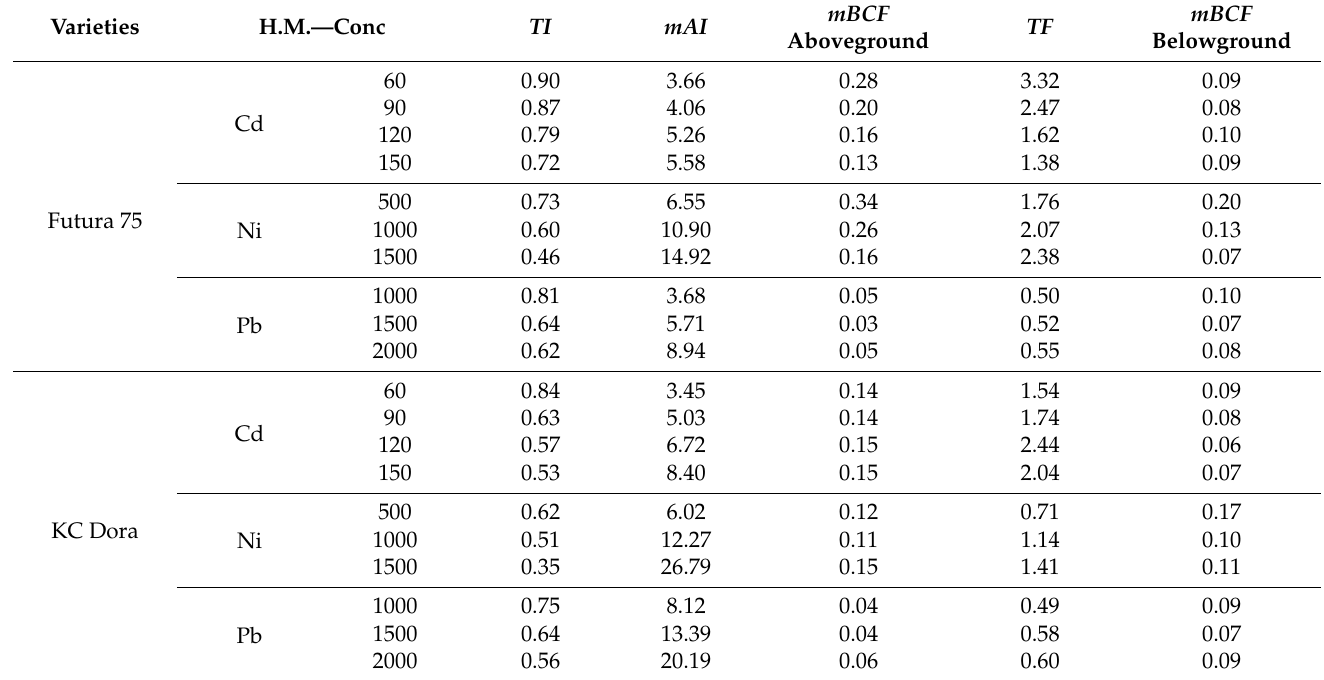
Table 6. Phytoremediation indices and factors of phytoremediation extraction of Futura 75 and Kc Dora. Varieties